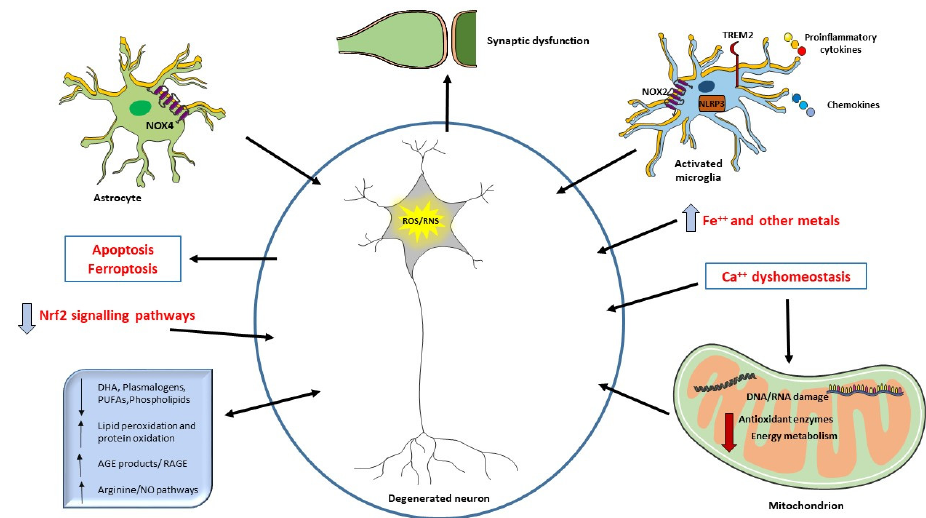
Figure 1. The neurodegeneration occurring in AD can be related to ROS overproduction and/or a decrease in antioxidant defenses. A β deposition can also be directly responsible for ROS increase when it interacts with microglial surface receptors or mitochondria. Mitochondria are the primary source of ROS but also a target of ROS and alteration in energy metabolism have been described in AD patients. ROS may also be considered a second messenger and induce different signaling pathways or the synthesis of antioxidant enzymes (Nrf2). Oxidative damage to mitochondrial DNA and RNA, proteins, and lipids are detected in AD brain. Increased levels of iron and other metals can be responsible of ROS production and iron has been related to ferroptosis. Ca ++ influx alterations and the consequent mitochondrial dysfunction are also crucial in oxidative damage. A β can trigger NO production, an RNS. Oxidative damage affects synapses, causing cognitive impairment in AD. Decreased levels of different lipids have been correlated with cognitive deficit in AD, suggesting their use as biomarkers or in potential clinical intervention.